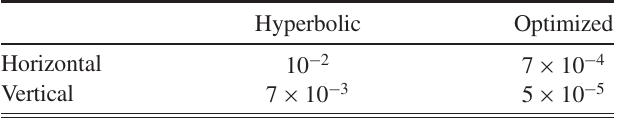
TABLE IV. Gradient inhomogeneities for hyperbolic and opti- mized pole shapes. The inhomogeneities are expressed at 7 mm in the horizontal plane and 5 mm in the vertical plane (RADIA simulations).